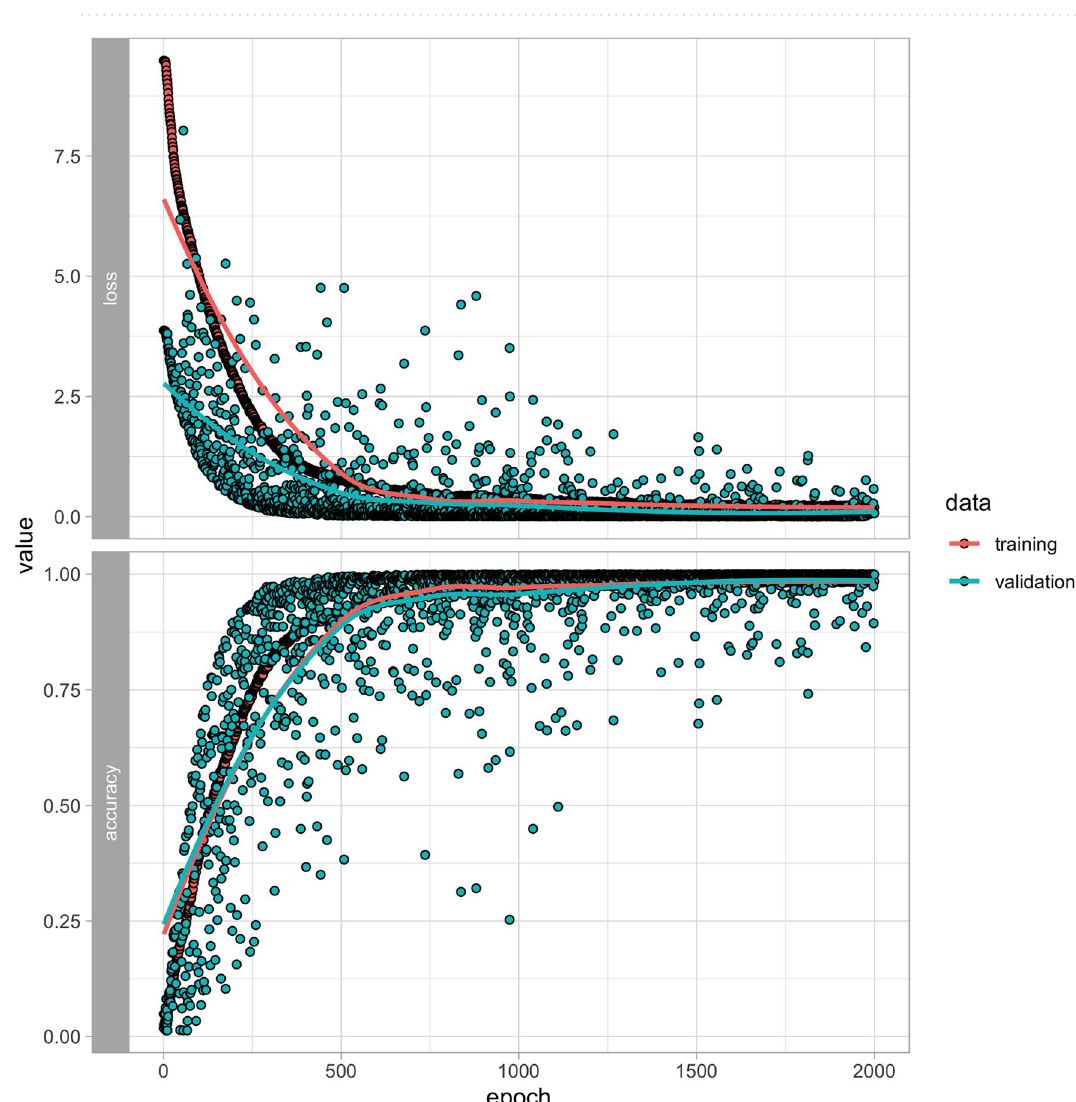
Figure 3. Training and validation loss (top) and accuracy (bottom) for the training (n = 14,672) and validation (n = 2590) portions of the full dataset. Models converged most of the time after 500 epochs, though considerable variation in validation accuracy is seen throughout